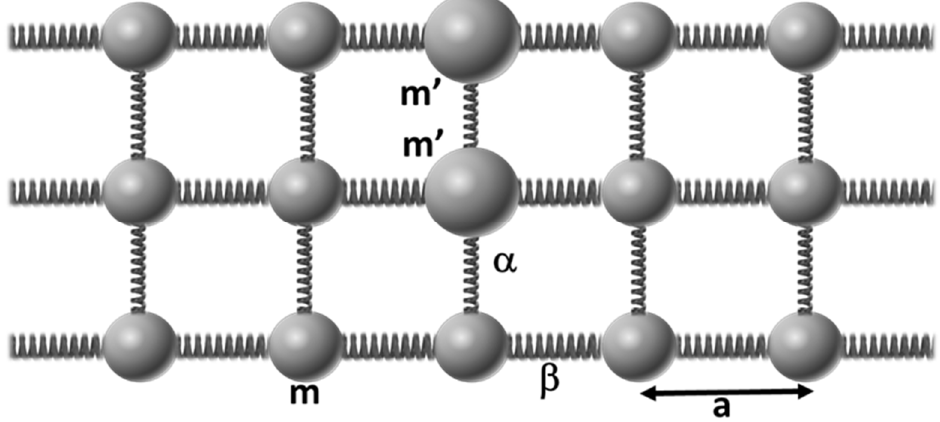
Figure 3. Schematic illustration of the system composed of three coupled one-dimensional elastic waveguides with two mass defects (two larger spheres with mass m’).